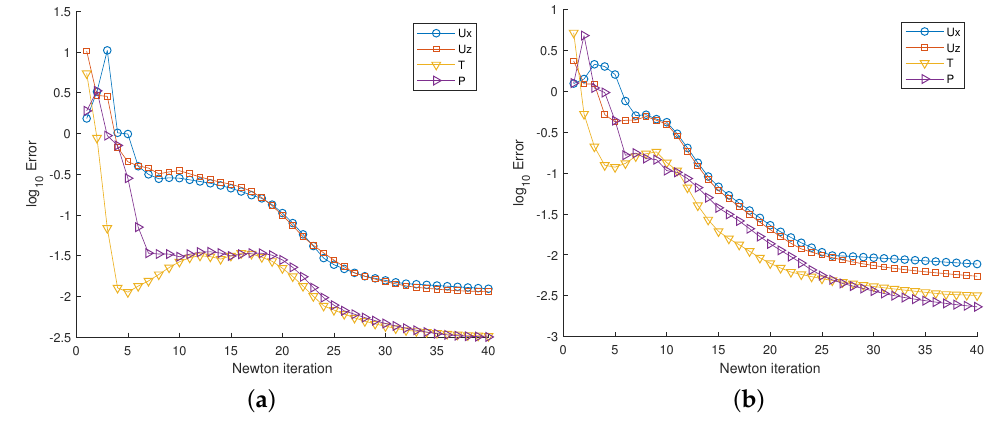
Figure 21. Graph of the log 10 of the errors in the velocity, temperature, and pressure fields for the Newton iterations: ( a ) R = 1300, Γ = 27.96, np = 14, mp = 2, N × M = 16 × 10; ( b ) R = 5000, Γ = 27.96, np = 13, mp = 3, N × M = 18 × 12.